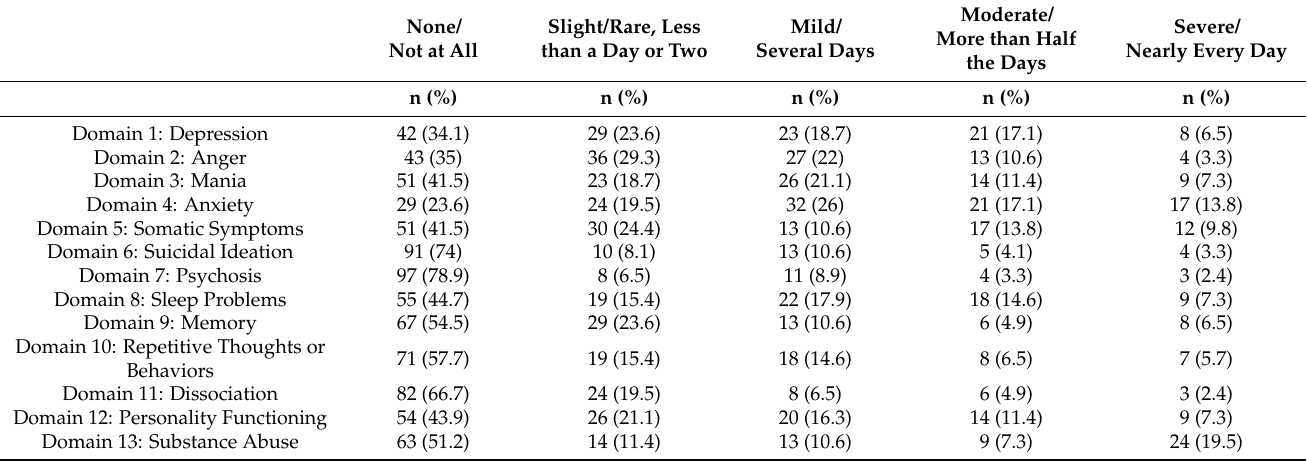
Table 3. Percentage of college students in each score category for each domain in the DSM-5 Self-Rated Level 1 Cross-Cutting Symptom